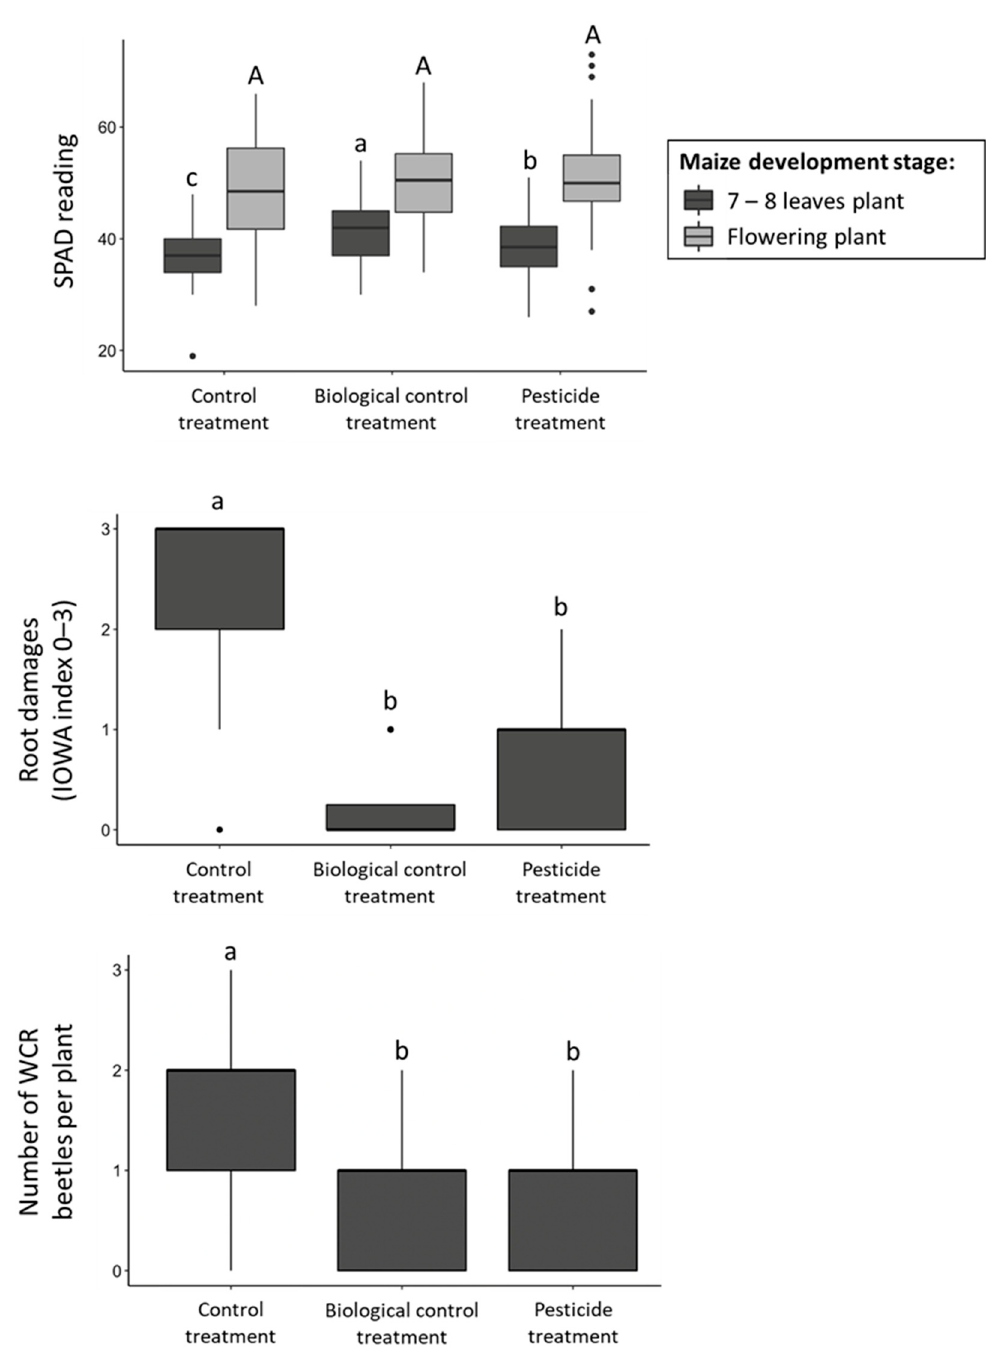
Figure 2. Field trial. Impact of the treatment type (control, biological control through the use of predatory mites and pesticide treatments) on the maize chlorophyll index (SPAD-reading; top panel), the root-damage index (IOWA index: 0–3; middle panel) and total number of WCR adults emerging per plant ( low panel). Boxplot topped by the same letters did not differ significantly.